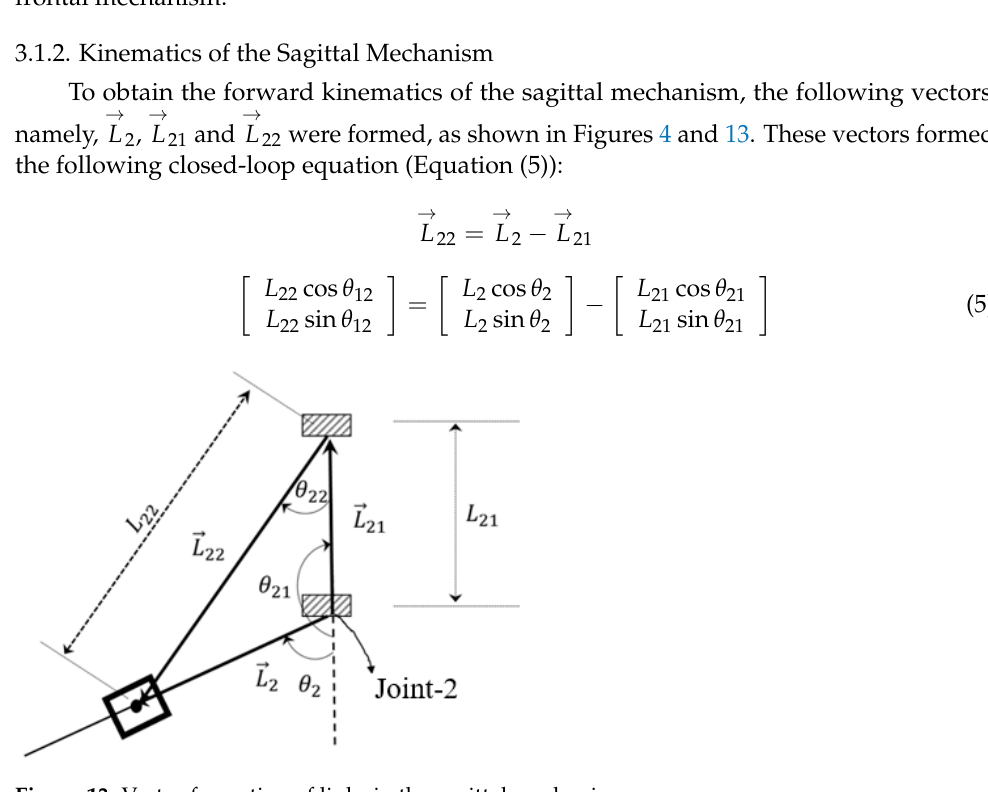
Figure 13. Vector formation of links in the sagittal mechanism.